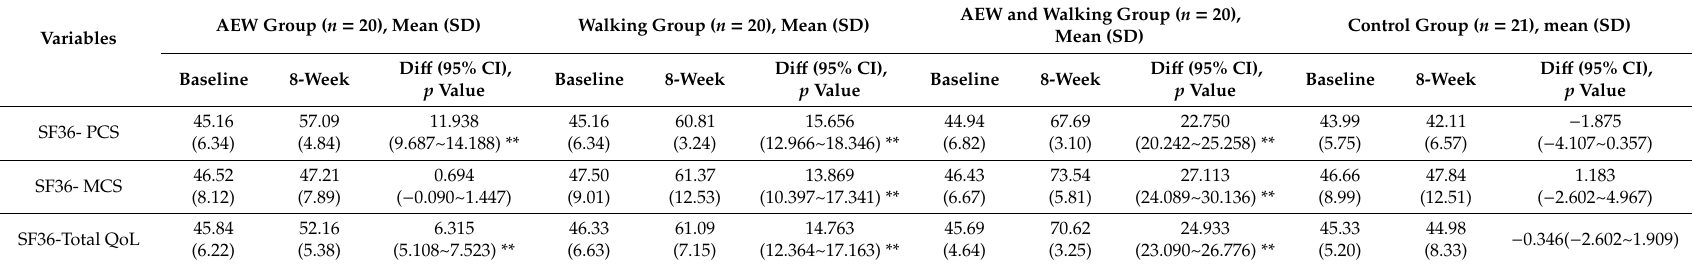
Table 4. Quality of life before and after the intervention in participants with T2DM ( n =